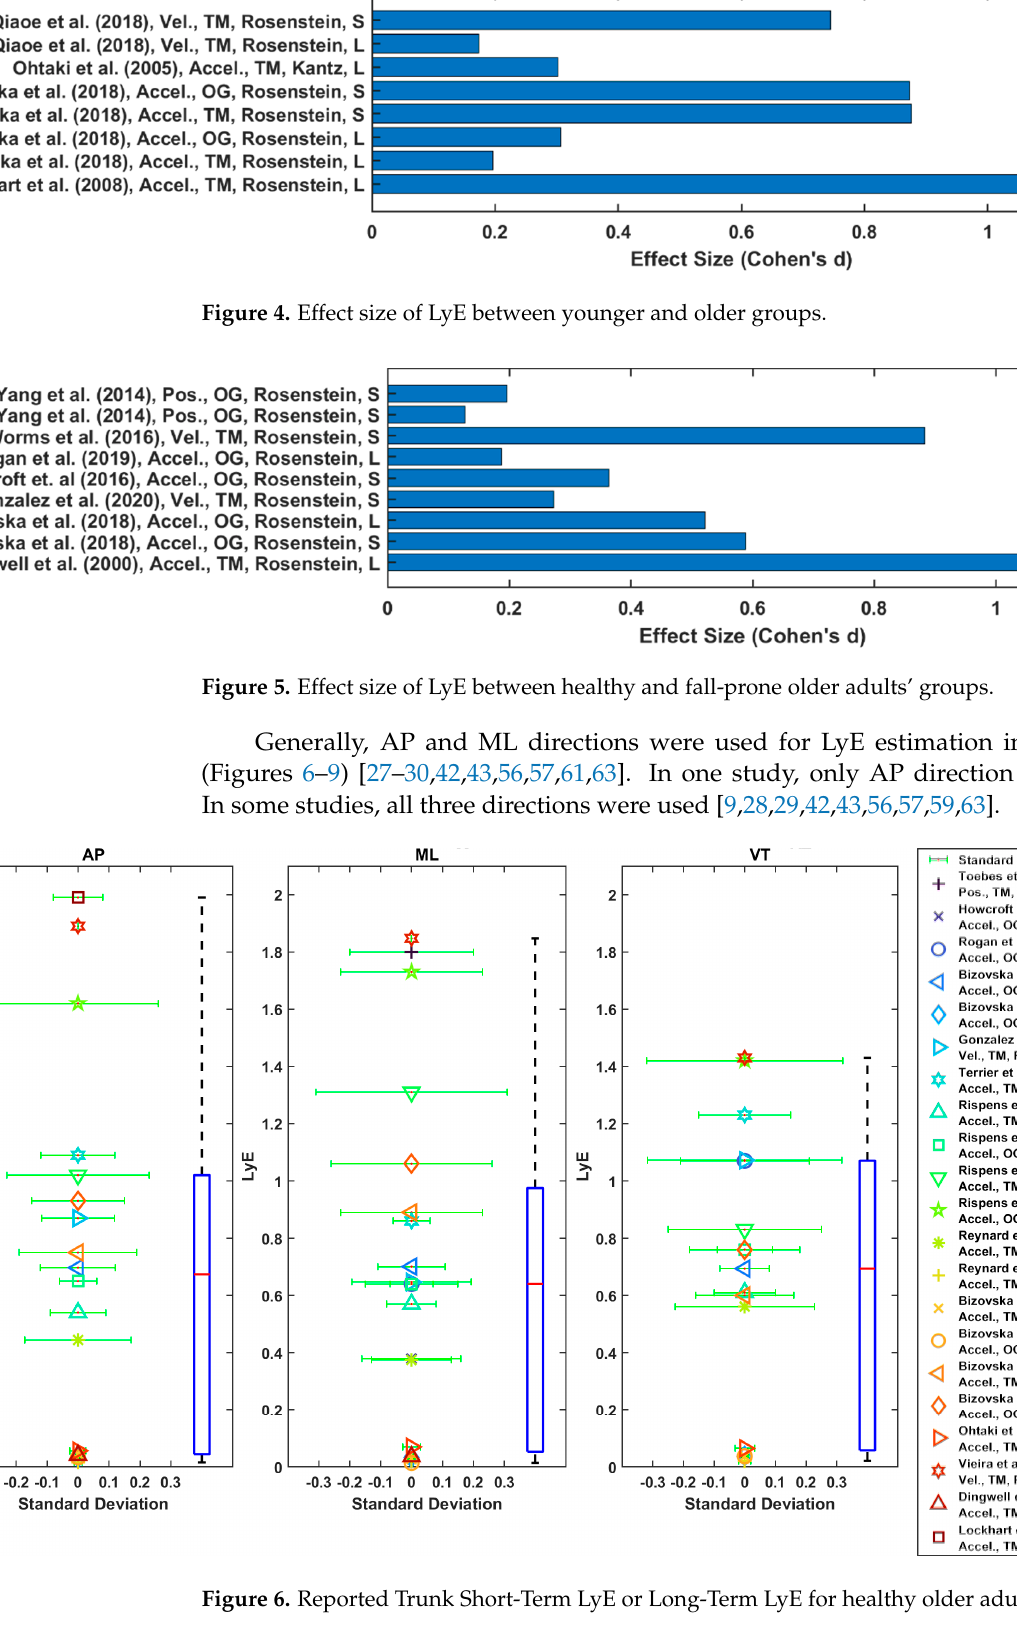
Figure 7. Reported Trunk Short-Term LyE or Long-Term LyE for fall-prone adults.